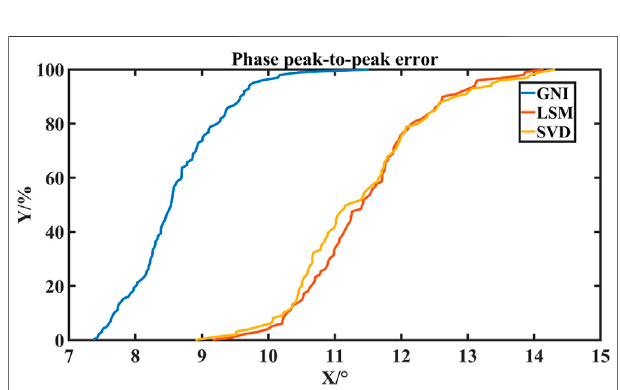
TABLE 4 | Comparison of simulation of different algorithms in 4.9